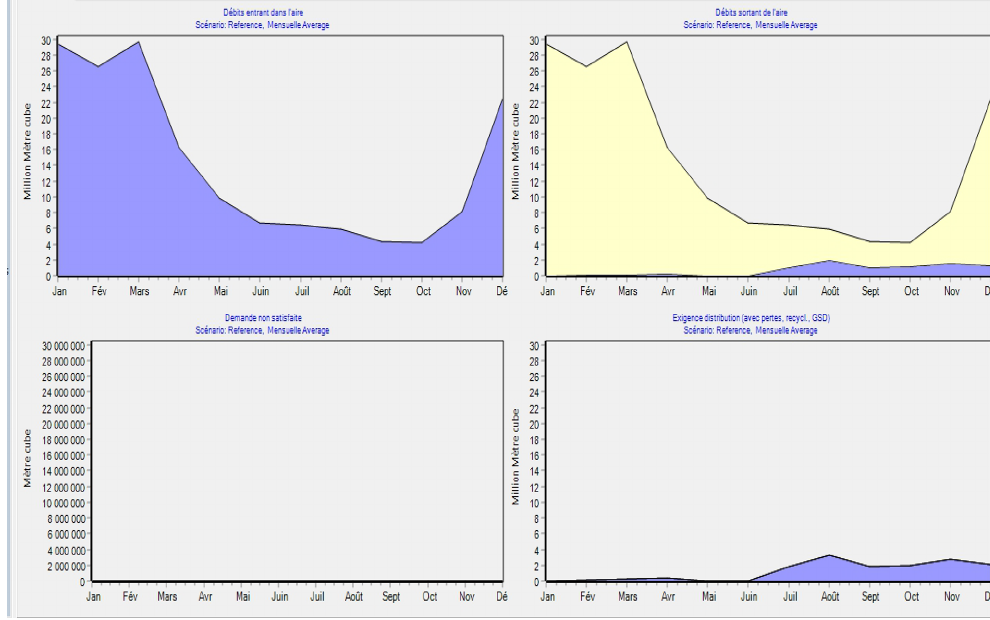
Figure 10. Débit entrant, débit sortant, demande non satisfaisante, exigence de distribution (Modélisation avec